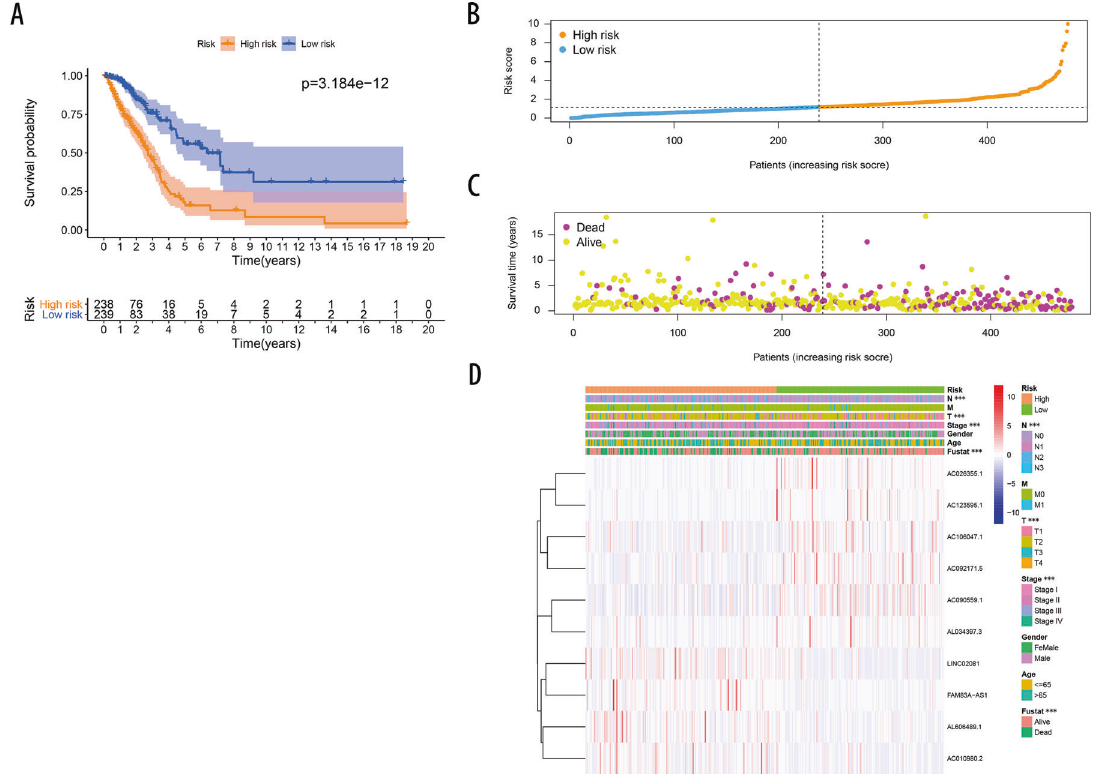
Fig. 3 Prognostic value of the risk model including 10 ferroptosis-related lncRNAs. A Kaplan – Meier curves for OS in the high-risk and low- risk groups strati fi ed by FerRLSig ( P < 0.0001). B Risk curve based on the risk score for each sample, where orange indicates a high risk and blue indicates a low risk. C Scatterplot based on the survival status of each sample. Yellow and violet dots indicate survival and death, respectively. D The heatmap shows the distribution of 10 ferroptosis-related lncRNAs and clinicopathological parameters in the high-risk and low-risk groups in the TCGA-LUAD